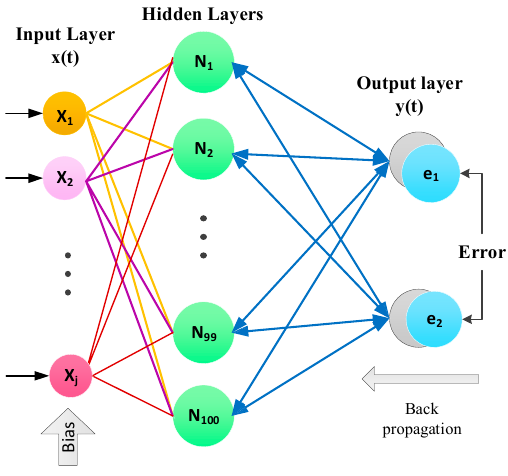
Figure 3. Structure of two layers of neural networks.